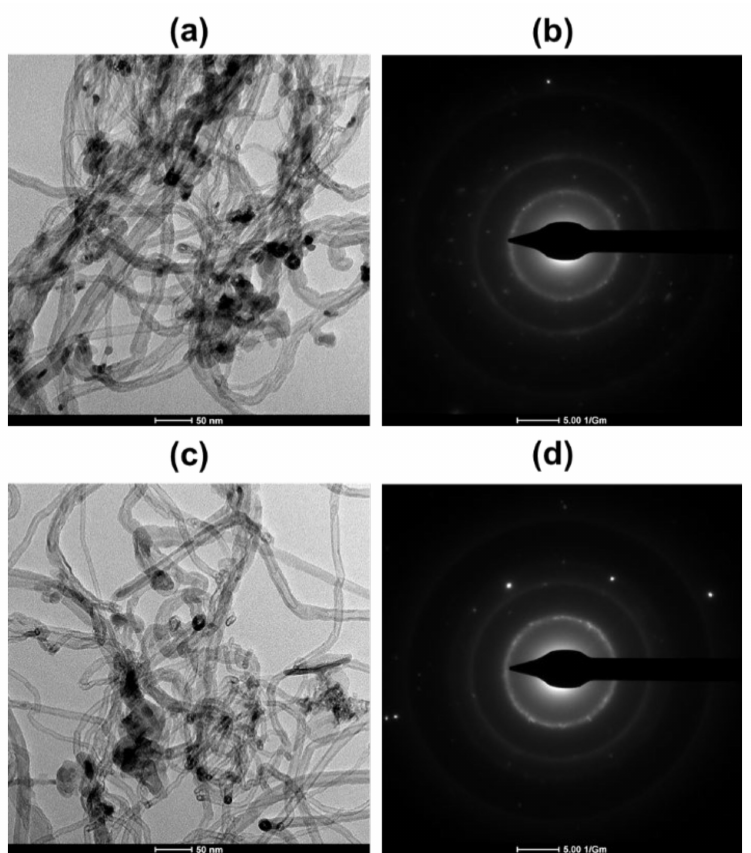
Figure 4. HRTEM images of ( a ) MWCNTs-CeO 2 and ( b ) MWCNT-Yb 2 O 3 (1:4 mass ratio) prepared by sonication in presence of Nafion, and SAED patterns ( c ) MWCNTs/CeO 2 and ( d ) MWCNTs/Yb 2 O 3 .